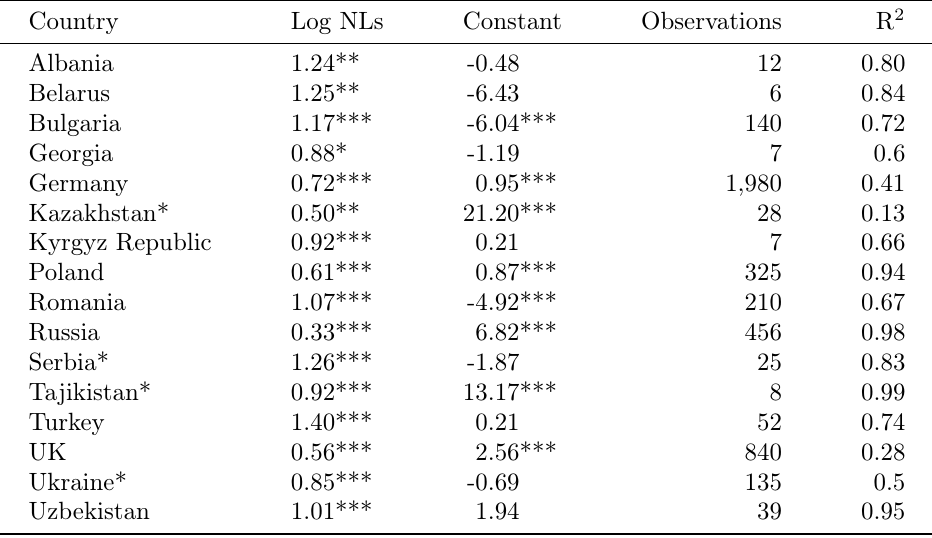
Table C.1: NLs as proxy of economic